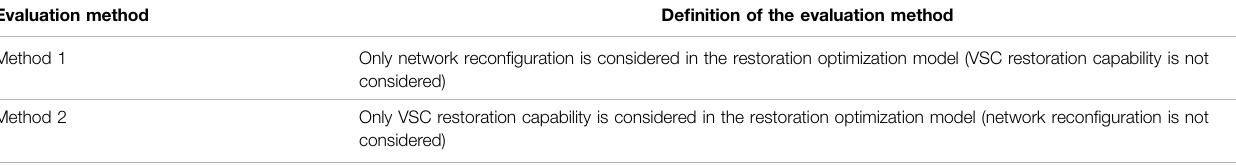
TABLE 4 | De fi nition of the evaluation methods. Evaluation method De fi nition of the evaluation method Method 1 Method